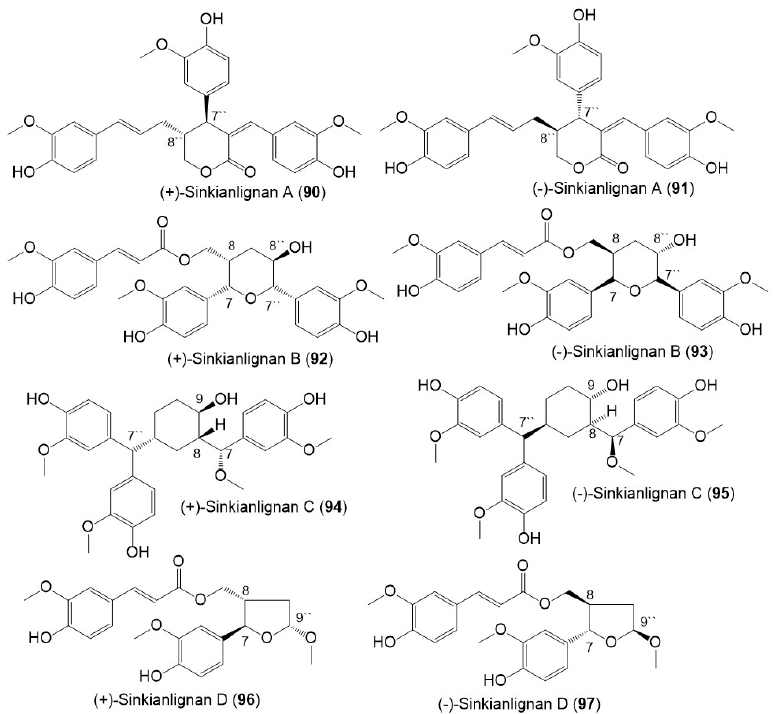
Figure 12. Structures of lignans ( 90 – 97 ) reported from F. sinkiangensis .